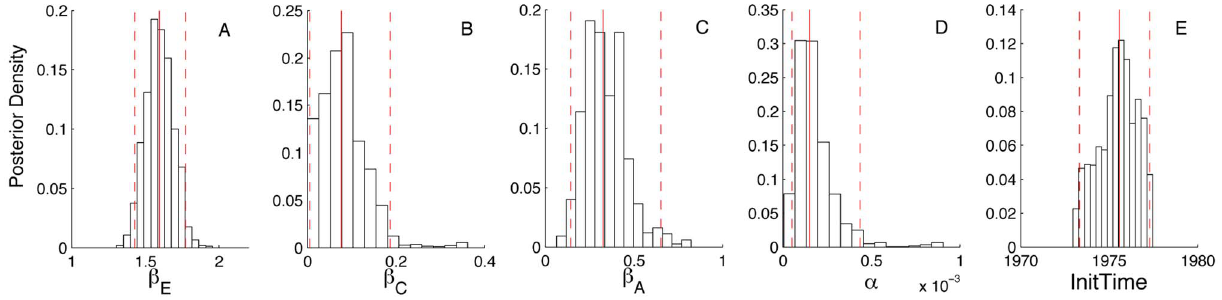
Figure 2. Posterior densities of parameters inferred from one HIV genealogy. Solid red lines mark the median values and dashed lines indicate the 95% credible intervals. The estimated parameters are the early stage transmission rate b E , the chronic stage transmission rate b C , the AIDS stage transmission rate b A , the incidence scaler a and the initial introduction time of HIV into Detroit.